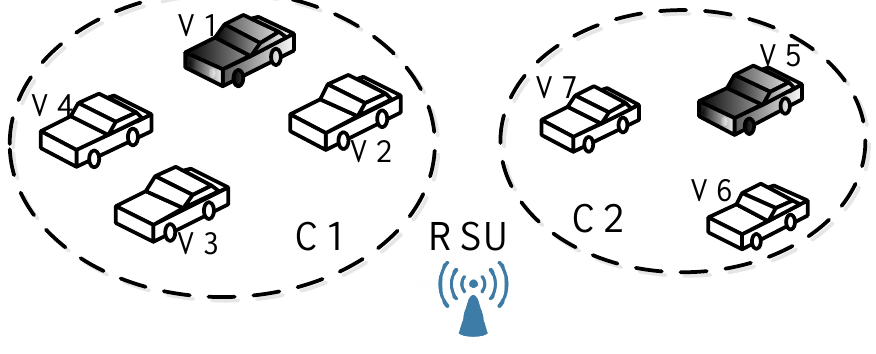
Figure 8. Considered clustering